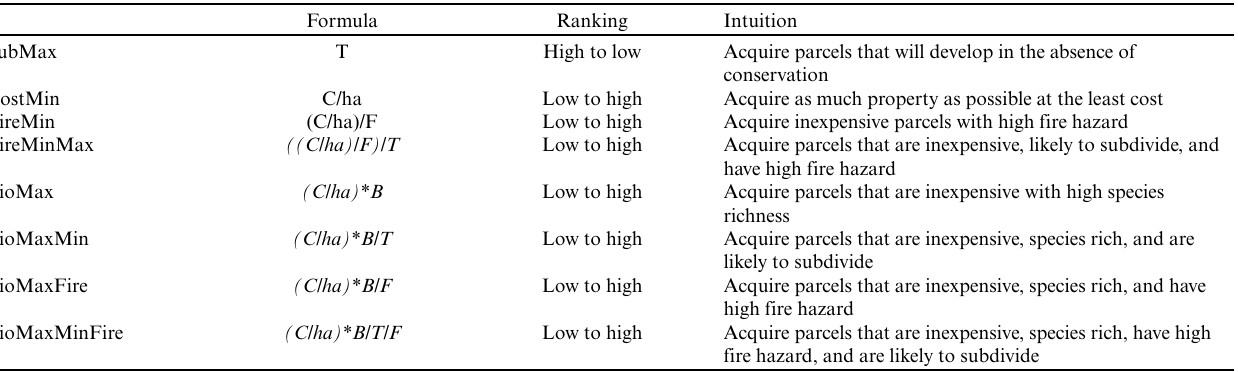
Table 1 . Description of conservation selection algorithms. Selection algorithms for conserving parcels. C is equal to the cost of conservation; ha is equal to the size of the parcel; T is equal to the transition probability of the parcel; F is equal to the fire hazard of the parcel (higher values for higher hazard); B is equal to the species richness score (low values correspond to richness rankings). Formula Ranking Intuition SubMax T High to low CostMin C/ha Low to high (C/ha)/F Low to